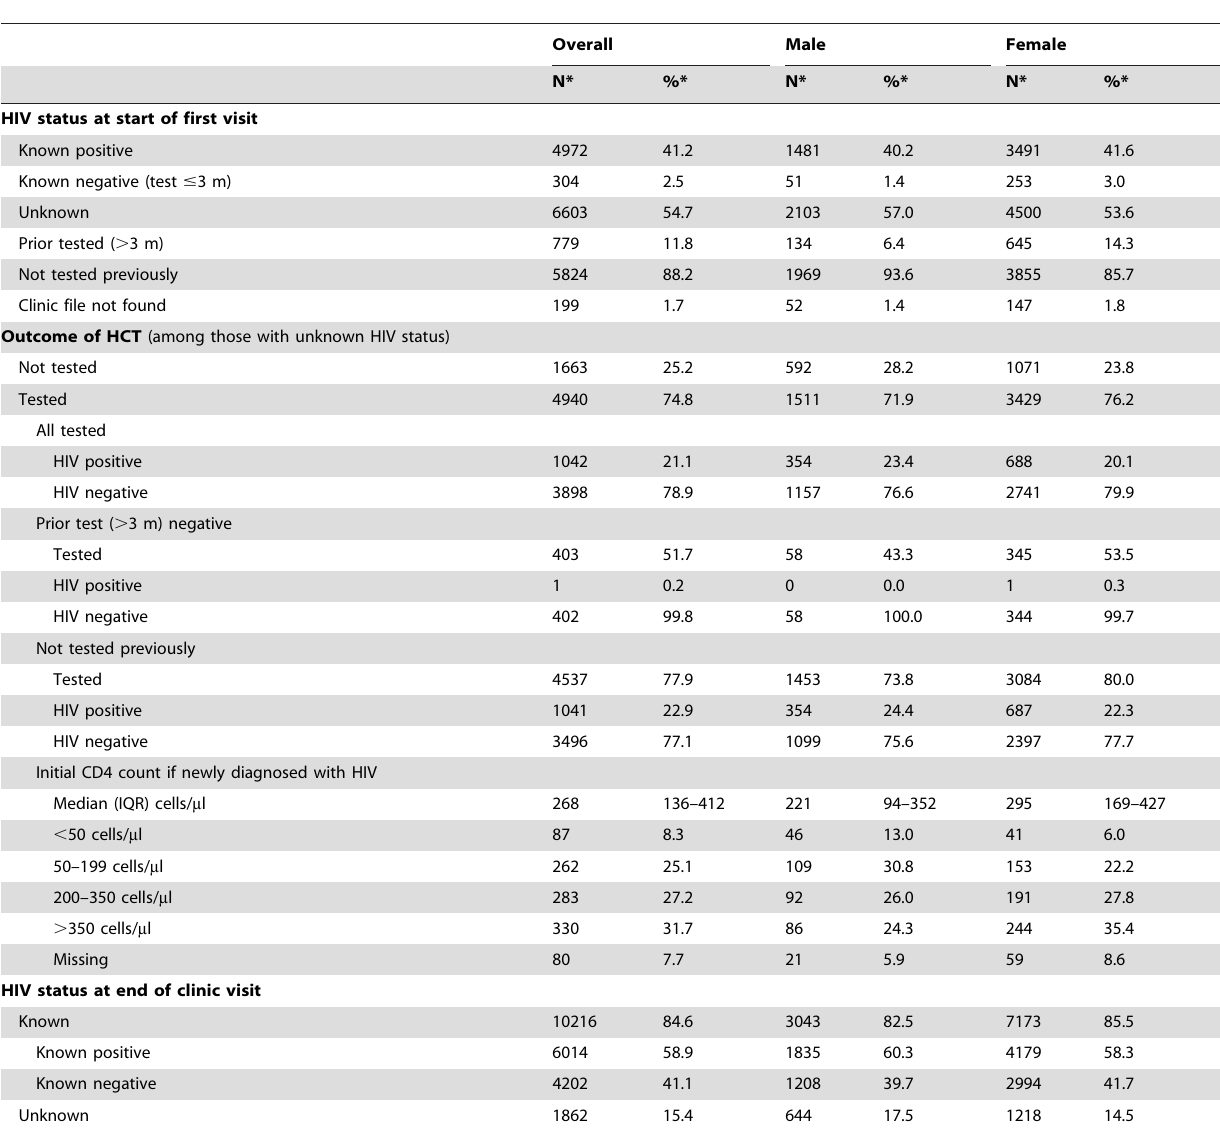
Table 2. Uptake and results of HIV counseling and testing among 12,078 individuals visiting a primary care clinic in Johannesburg, South